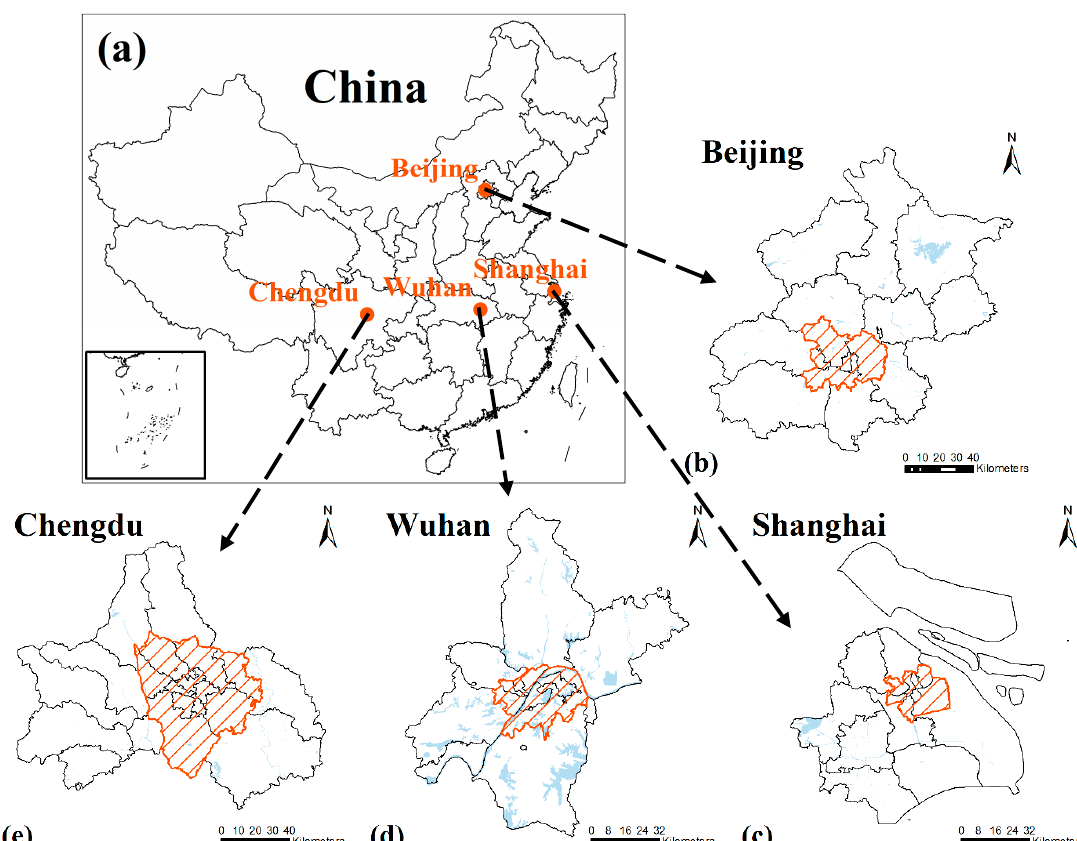
Figure 1. The study areas: ( a ) map of China; ( b ) map of Beijing, China; ( c ) map of Shanghai, China; ( d ) map of Wuhan, China; ( e ) map of Chengdu, China. The shaded area refers to the central urban areas of each city.